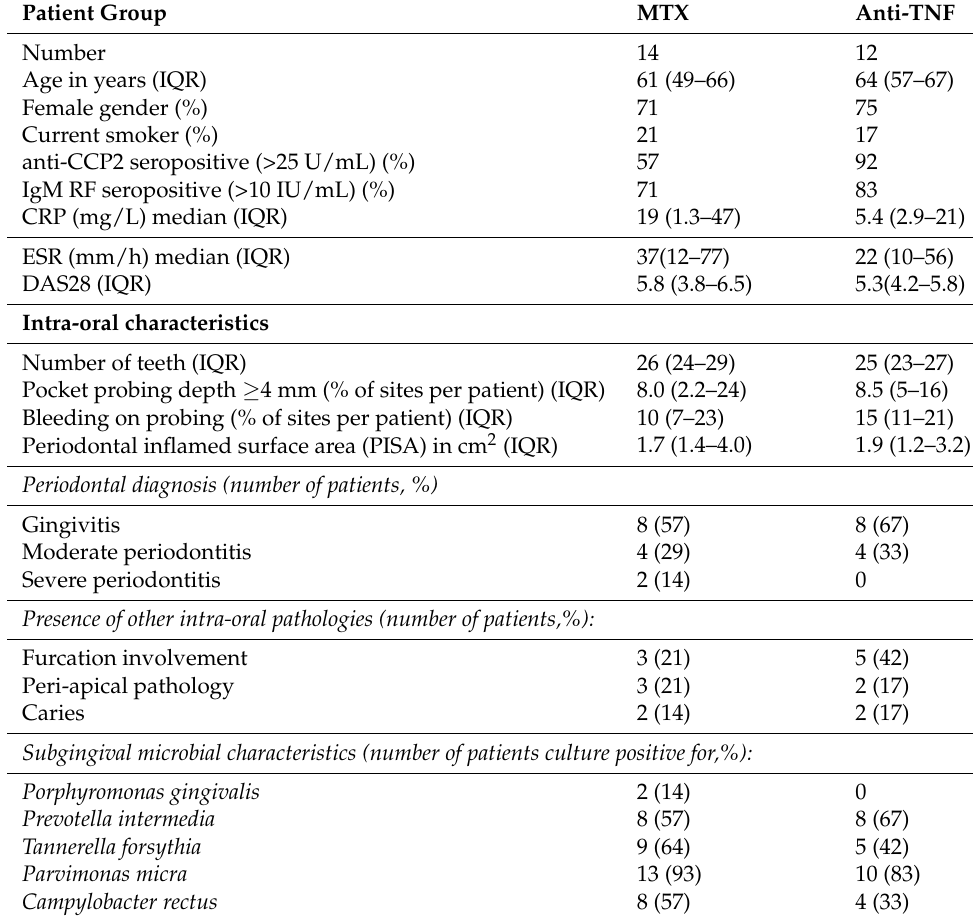
Table 1. Patient characteristics at baseline (IQR: interquartile